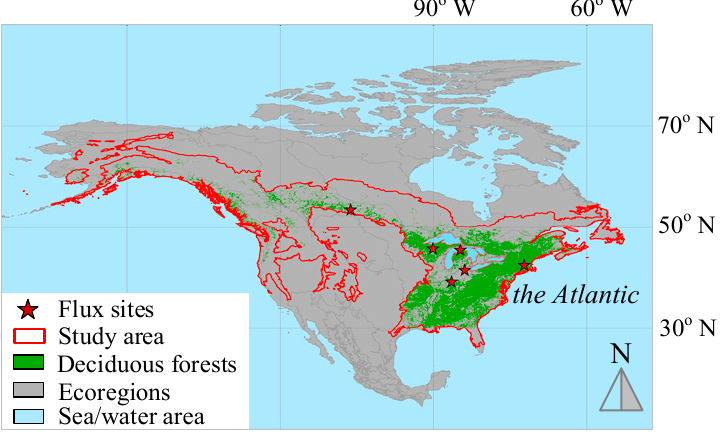
Figure 1. The study area of North America. Deciduous forests are extracted from MODIS MCD12Q1 for the year of 2020. for the year of